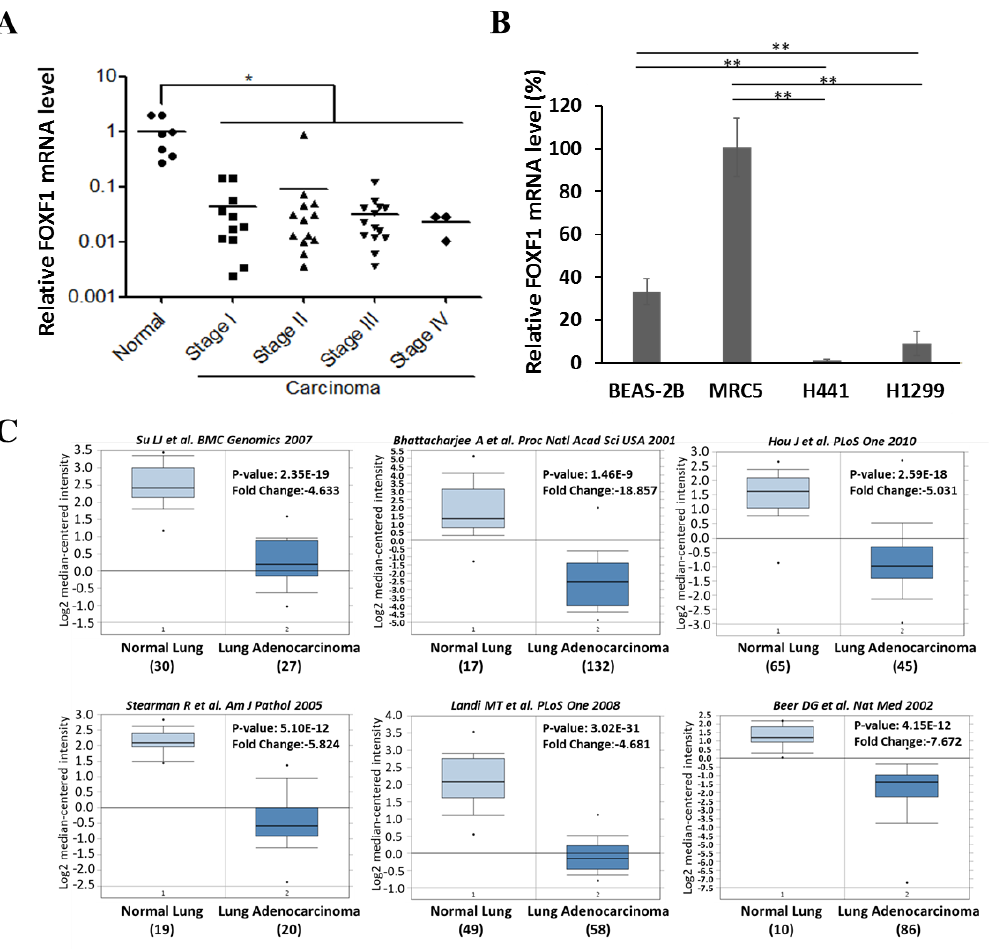
Figure 1. Downregulation of forkhead box F1 (FOXF1) in lung cancer. ( A ) Real-time PCR-dependent FOXF1 messenger RNA (mRNA) levels in lung cancer ( n = 41) and normal lung tissues ( n = 7). The relative mRNA level was stratified at dot plots according to the cancer grade. * p < 0.01, using Welch’s unpaired t- test. ( B ) FOXF1 mRNA levels in BEAS-2B, MRC5, H441, and H1299 cells. ( C ) In silico analysis of FOXF1 expression using Oncomine Research Edition (https://www.oncomine.org/). FOXF1 mRNA expressions in normal and malignant lung specimens are presented as box and whisker plots. The authors, published journal, and year of each study are indicated under the graph. The number of the sample (listed under each specimen), fold changes of the mRNA expression of FOXF1, and p- value are indicated in each panel. Data are expressed as means ± standard error (SE). * p < 0.05; ** p < 0.01, using Welch’s unpaired t- test.